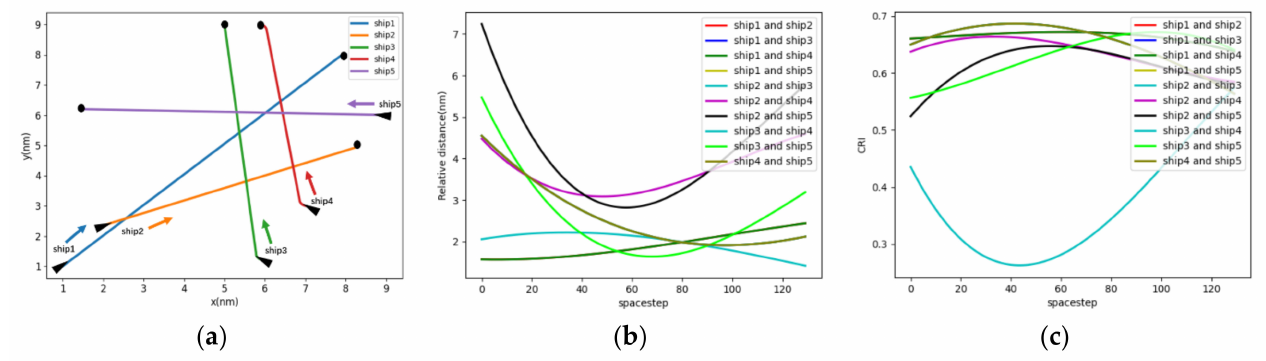
Figure 16. The CA result of four-ship encounter based on CS-STHA. ( a ) trajectories; ( b ) relative distance; ( c ) CRI.